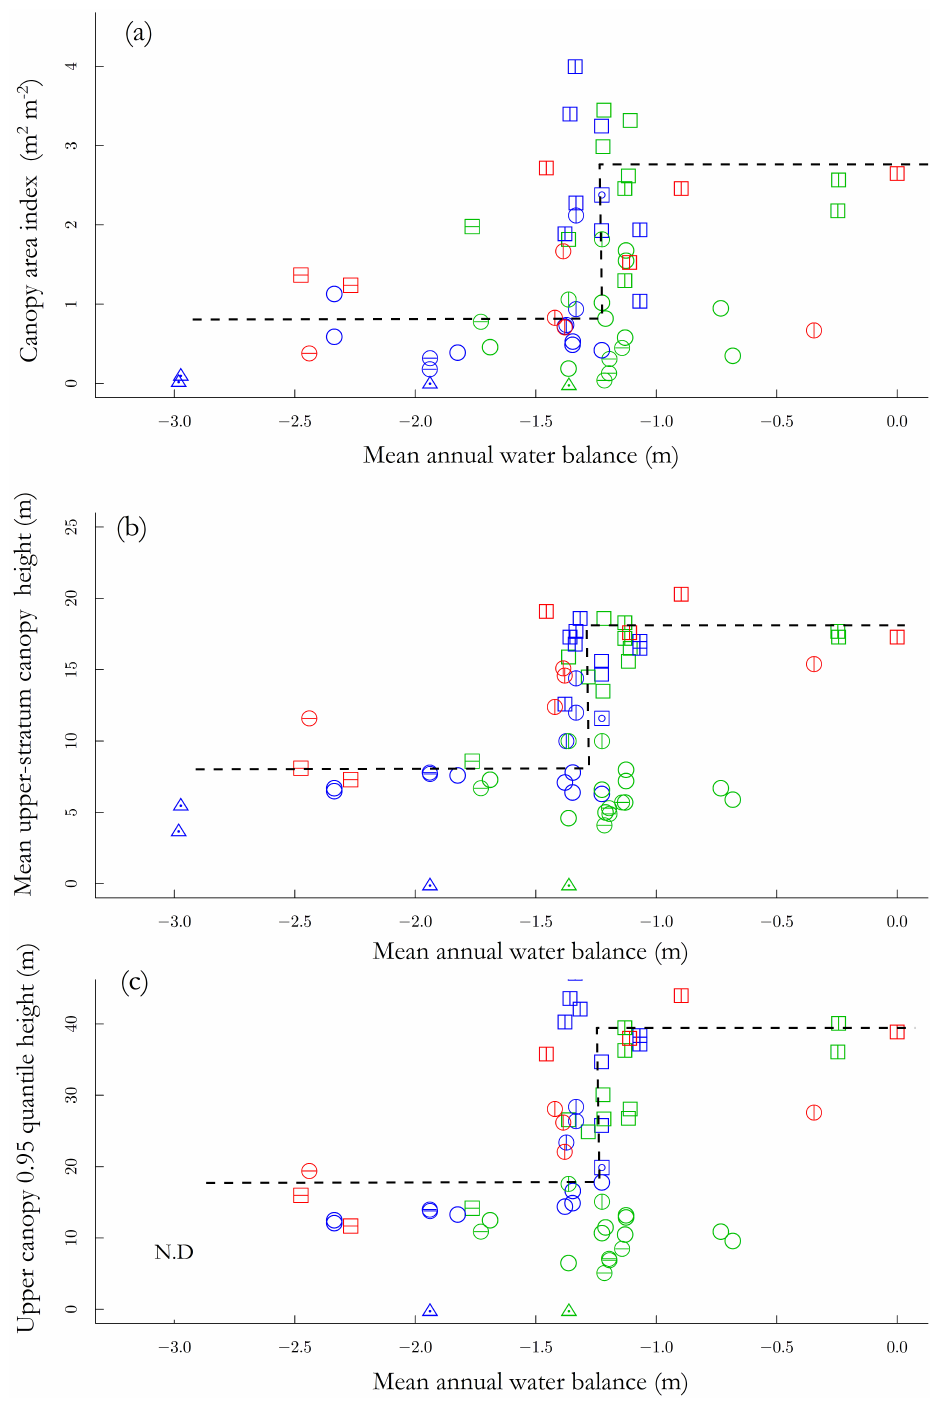
Figure 2. Relationship between estimated mean annual water balance and (a) total woody plant canopy area index; (b) mean upper-stratum canopy height and (c) upper stratum 0.95 quantile height. Symbols as in Fig. 1 with lines fitted by